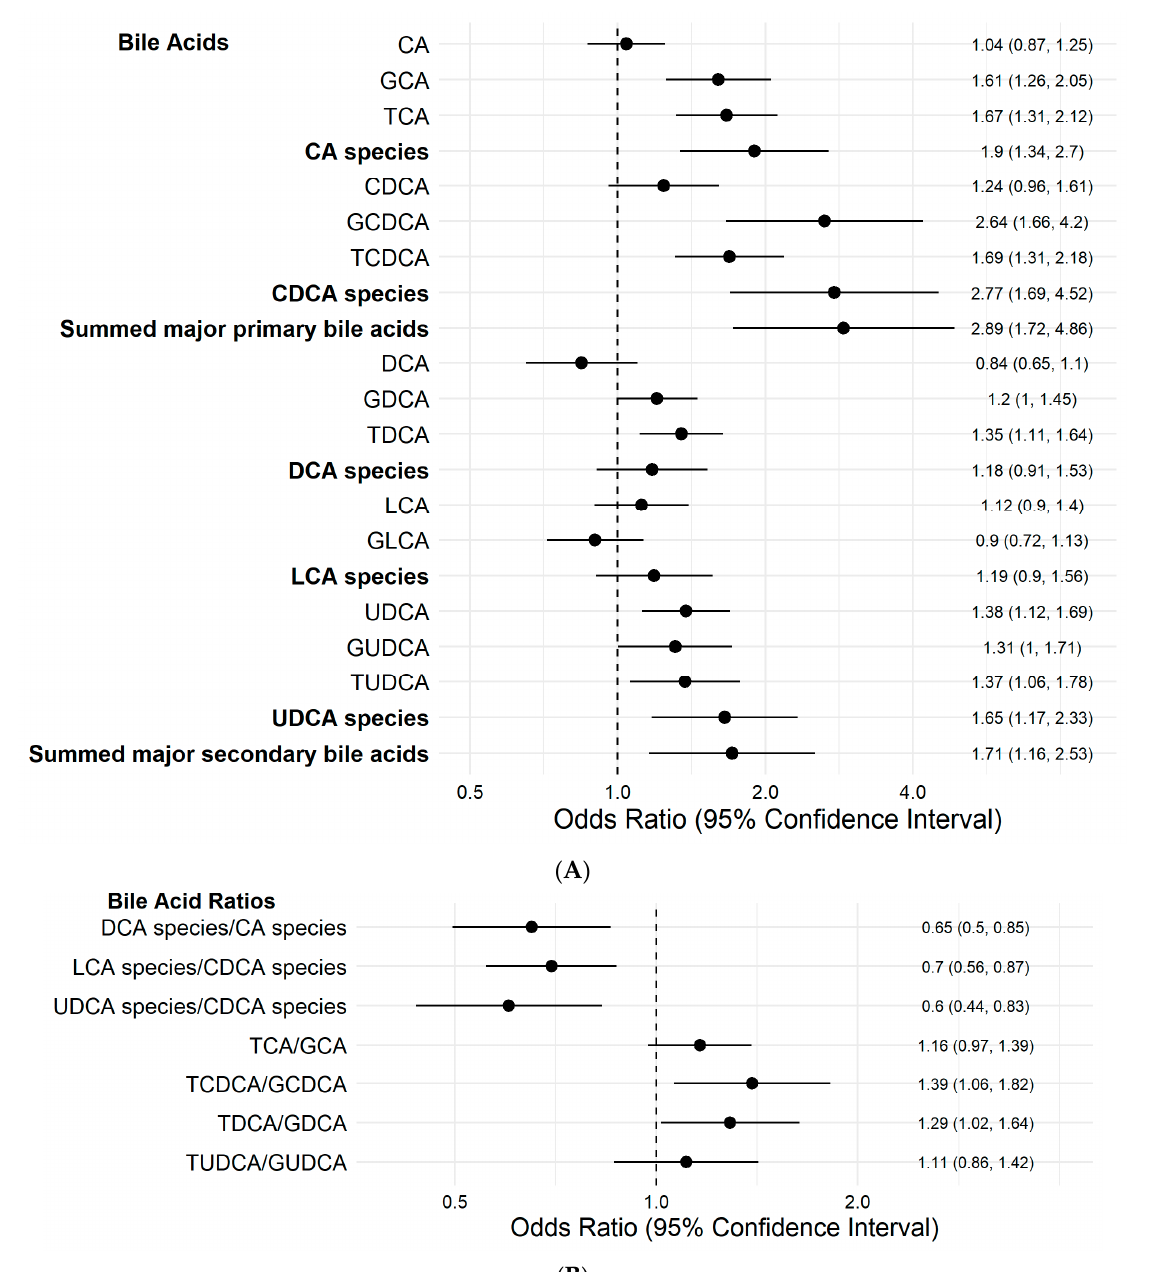
Figure 1. Odds ratios (95% confidence intervals) a of hepatocellular carcinoma associated with ( A ) doubling concentrations of bile acids, ( B ) doubling the ratio of secondary bile acid species over primary bile acids species and doubling the ratios of taurine-over glycine-conjugated bile acids, The Singapore Chinese Health Study. a Derived from conditional logistic regression models including the following covariates: HBsAg status, alcohol intake, cigarette smoking status, history of diabetes, body mass index, and time interval from the last meal to blood draw. Summed major primary bile acids: sum of CA species and CDCA species. Summed major secondary bile acids: sum of DCA species, LCA species, and UDCA species.